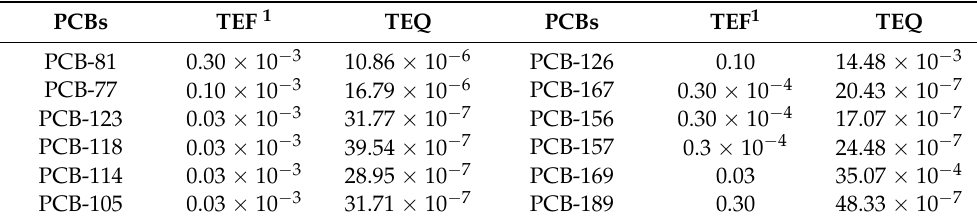
Table 2. The toxicity equivalents (TEQ) of 12 typical PCBS in the water of Beiluo River.